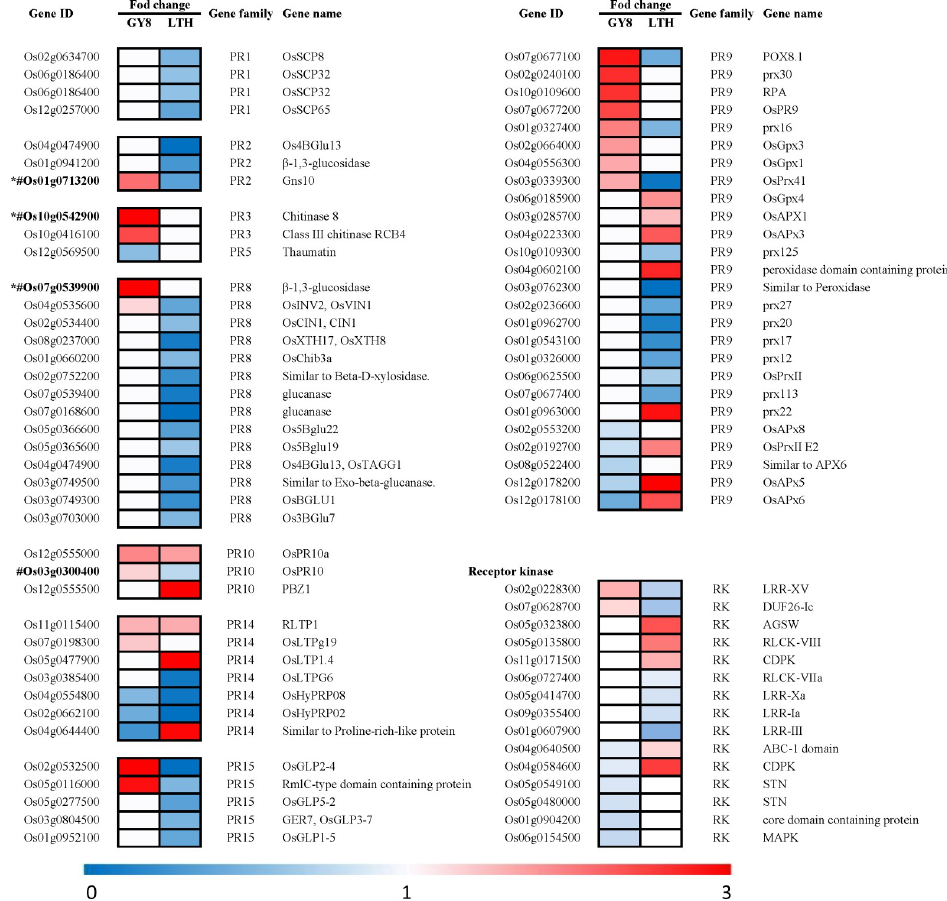
Fig 3. Heat maps showing the expression patterns of pathogenesis-related (PR) and receptor kinase (RK) genes that were identified as differentially regulated in durable resistant and susceptible rice by iTRAQ. The gene IDs and family names of the pathogenesis-related genes were obtained according to Dou [35]. The IDs of the RK genes were retrieved from the rice kinase database [36]. The gene names of the DEGs were obtained from the Rice Annotation Project Database (RAP-DB). The fold-change color of each gene represents the expression pattern of this gene. Red represents a fold-change greater than 1, indicating that this gene was up-regulated at 24 h post rice blast inoculation, and the lighter the color, the lower the up-regulated expression level. White represents a fold-change equal to 1, indicating no change, while blue represents a lower level of down-regulated expression with a darker color. See the scale at the bottom of the figure for details. � The transcript expression pattern of this gene was verified by qRT-PCR. # The protein expression pattern of this gene was verified by western blotting.